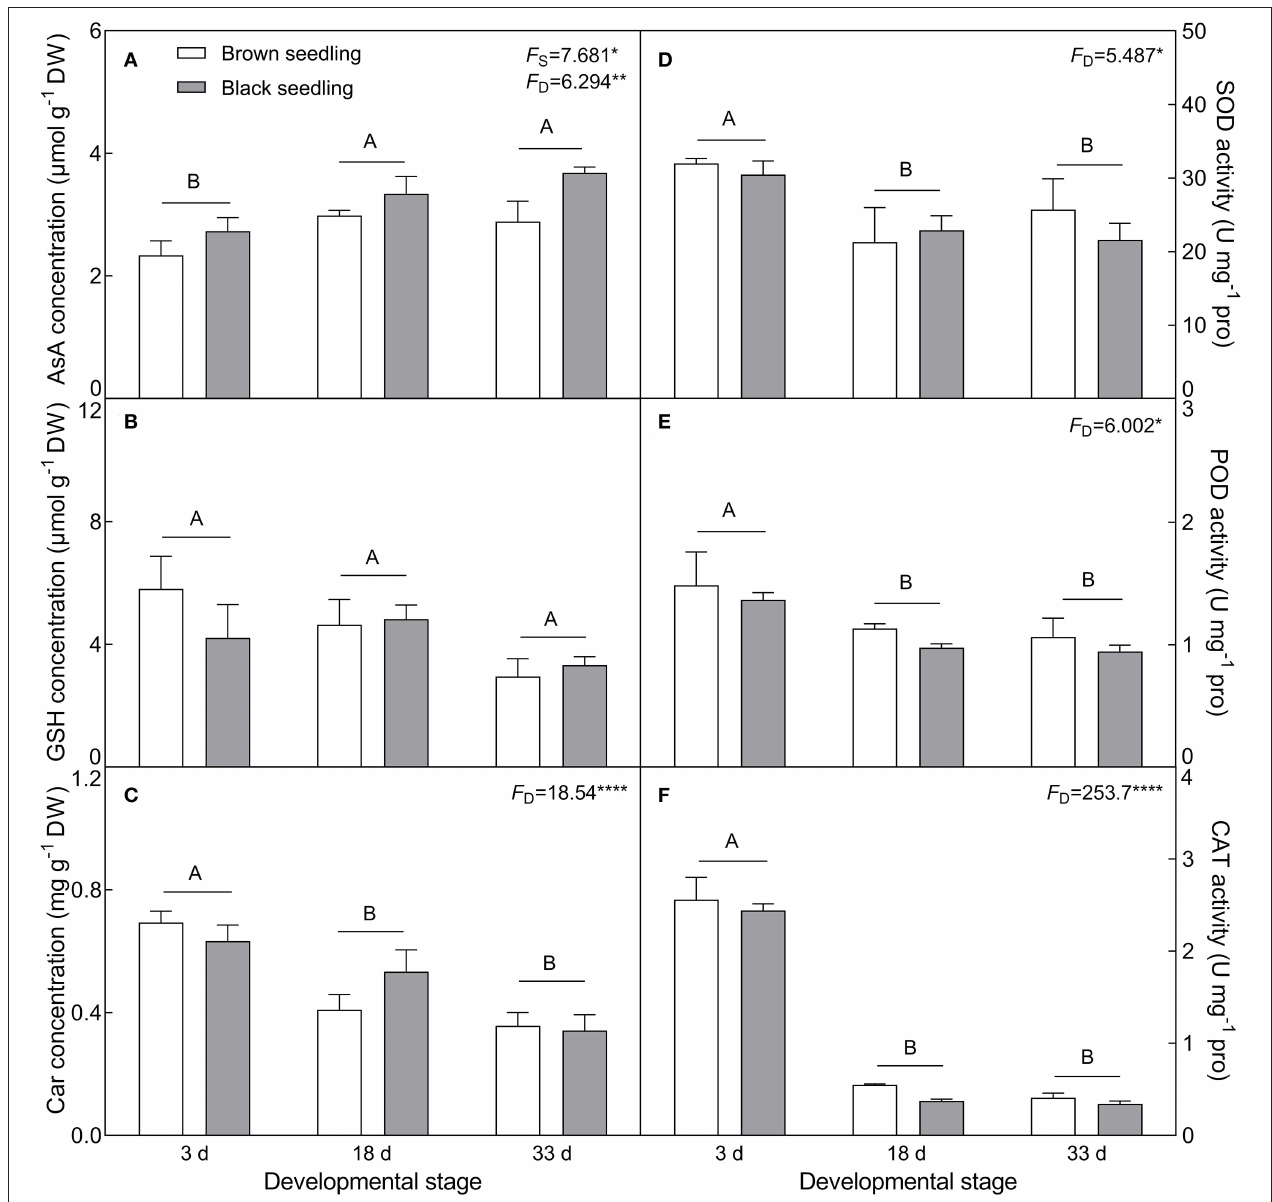
FIGURE 7 | Changes in the concentration of non-enzymatic antioxidants and activity of antioxidant enzymes during seedling development. (A) AsA, (B) GSH, (C) Car, (D) SOD, (E) POD, and (F) CAT. 3 d, 18 d, and 33 d represent 3, 18, and 33 days after seedling emergence, respectively. F -values are given when significance levels are reached (the subscript “D” represents “development”; “S”, “seed type”; * P < 0.05; ** P < 0.01; **** P < 0.0001). Bars with different uppercase letters indicate significant differences ( P < 0.05) according to Tukey’s test. Values are means ± SE of four replicates.